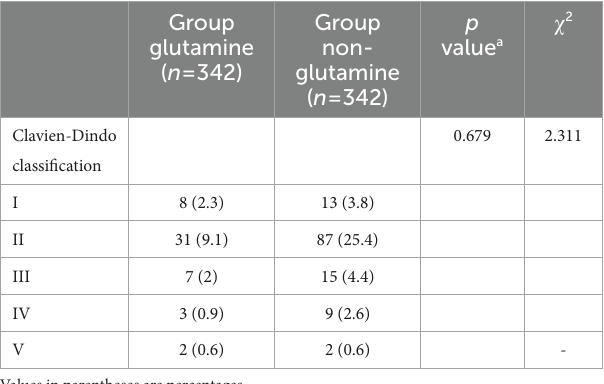
TABLE 3 Clavien-Dindo classification of postoperative complication after propensity score matching. Group